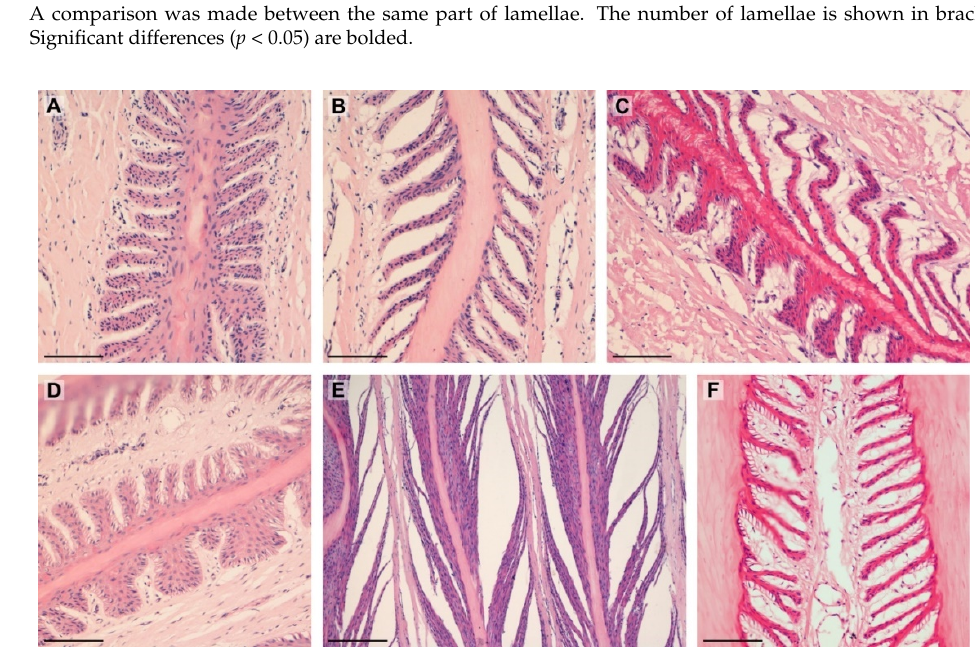
Figure 4. Types of SELs noted in the study: ( A )—suprabasal layer hyperplasia (lean); ( B )—tapered (lean); ( C )—tapering and suprabasal layer hyperplasia (obese); ( D )—fused and standard (lean); ( E )—separated (lean); ( F )—tapered (obese). Scale bar = 100 µm.